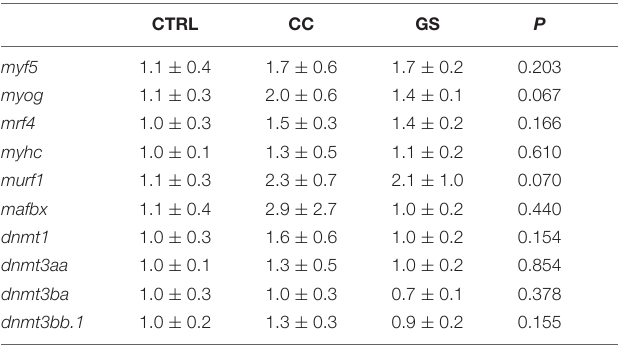
TABLE 4 | Expression of genes encoding for muscle development and epigenetic regulation: myf5, myog, mrf4, myhc, murf1, mafbx, dnmt1, dnmt3aa, dnmt3ba, and dnmt3bb.1 at 70 DAH ( n = 4).